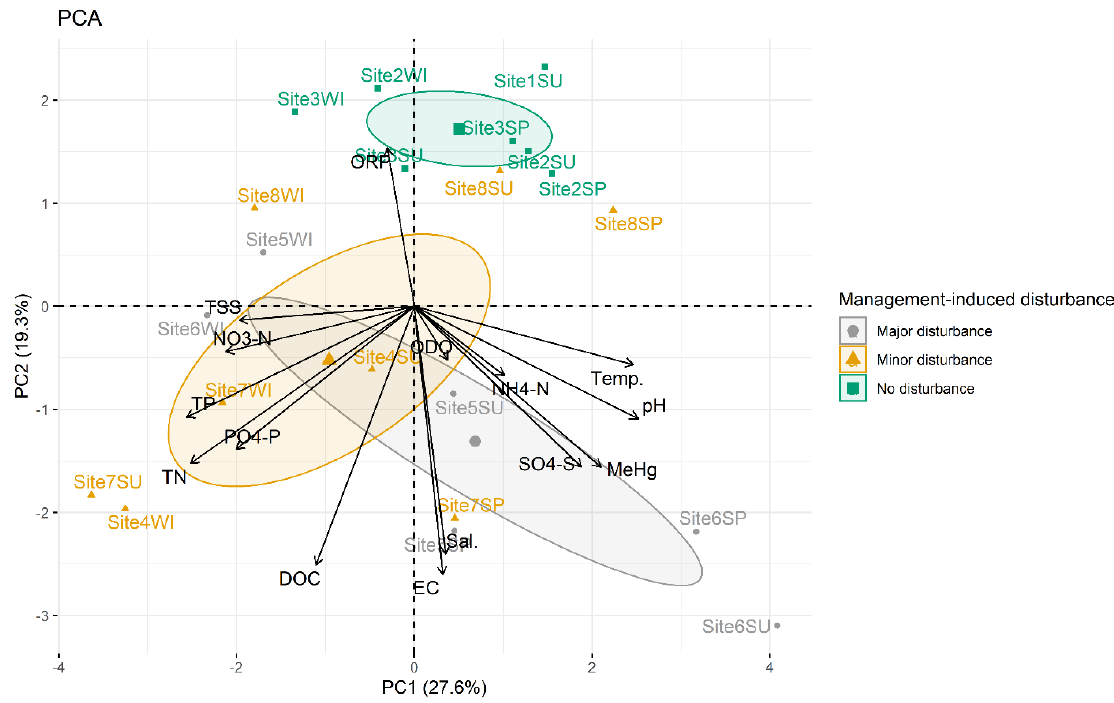
Figure 3. Principal component analysis (PCA) of physico-chemical parameters of water in small watercourses of drainage systems under different levels of management-induced disturbance. Arrows represent variable loadings. AU—autumn, WI—winter, SP—spring, SU—summer, DOC—dissolved organic carbon, EC—electrical conductivity, ODO—optical dis- solved oxygen, ORP—oxidation-reduction potential, Sal.—salinity, TN—total nitrogen, TP—total phosphorus, TSS—total phosphorus.